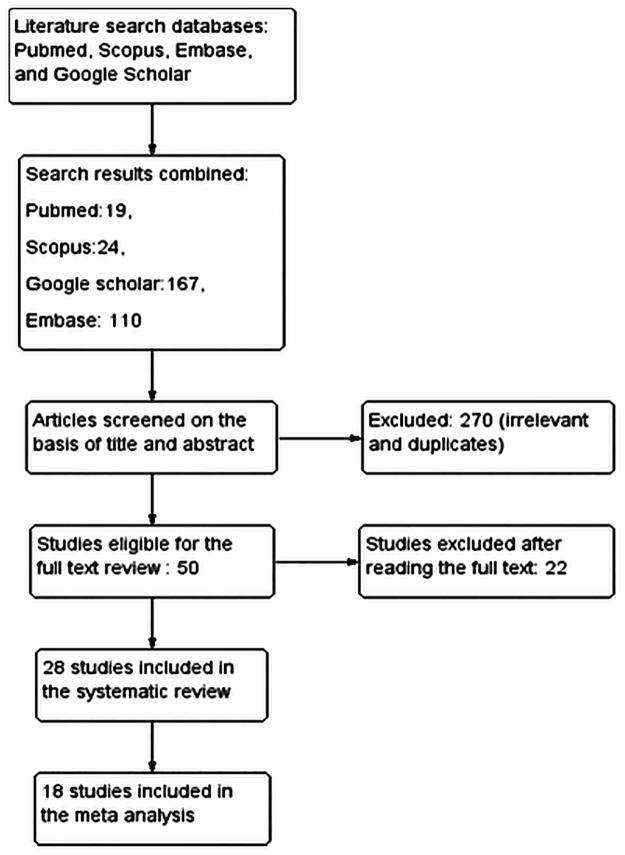
Flow of information through the different phases of the systematic review.